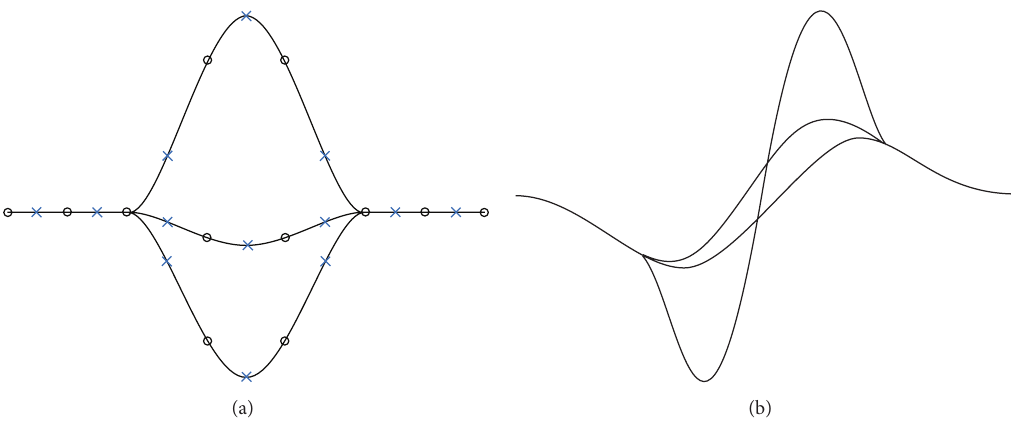
Figure 12: Examples of physically inadmissible mode shapes for a 3-layer delaminated beam obtained using 3-node elements (double- delamination model 1); 𝐻 2 = 0.3𝐻 1 , 𝐻 3 = 0.5𝐻 1 , and 𝑎/𝐿 = 0.5 . (a) off-delamination level partial pole 2nd mode (i.e., no vibrations at the intact segments), 𝜆 = 4.67. (b) interpenetration due to natural vibration 4th mode, 𝜆 =